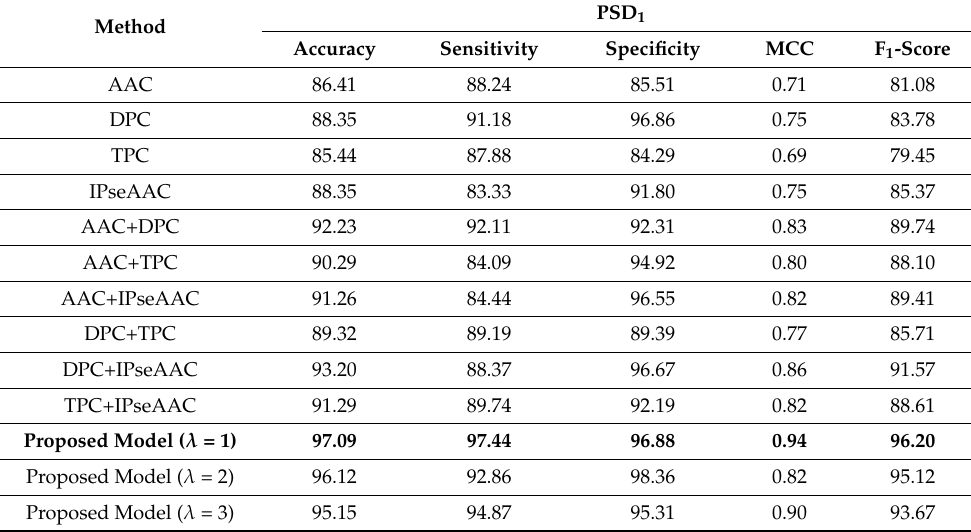
Figure 3. Performance evaluation of the proposed model over testing data of benchmark. Addition of physicochemical properties using the concept ( a ) ( λ = 1); ( b ) ( λ = 1); and ( c ) ( λ = 1). Table 3. Empirical results over numerous collections of feature extraction techniques using PCA and ensemble classifier where bold value represents the best